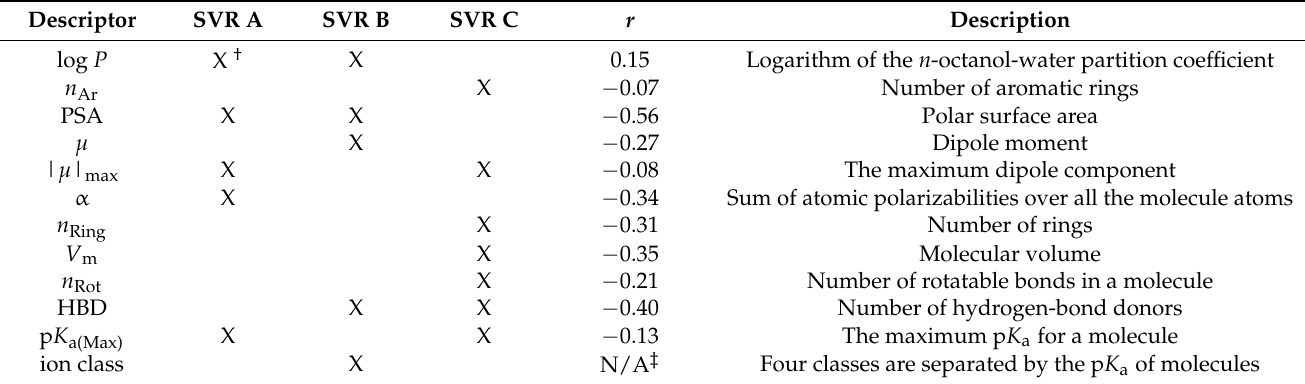
Table 1. The list of ensemble support vector regression (SVR) models and their descriptors, the correlation coefficient ( r ) with P app , and their descriptions.